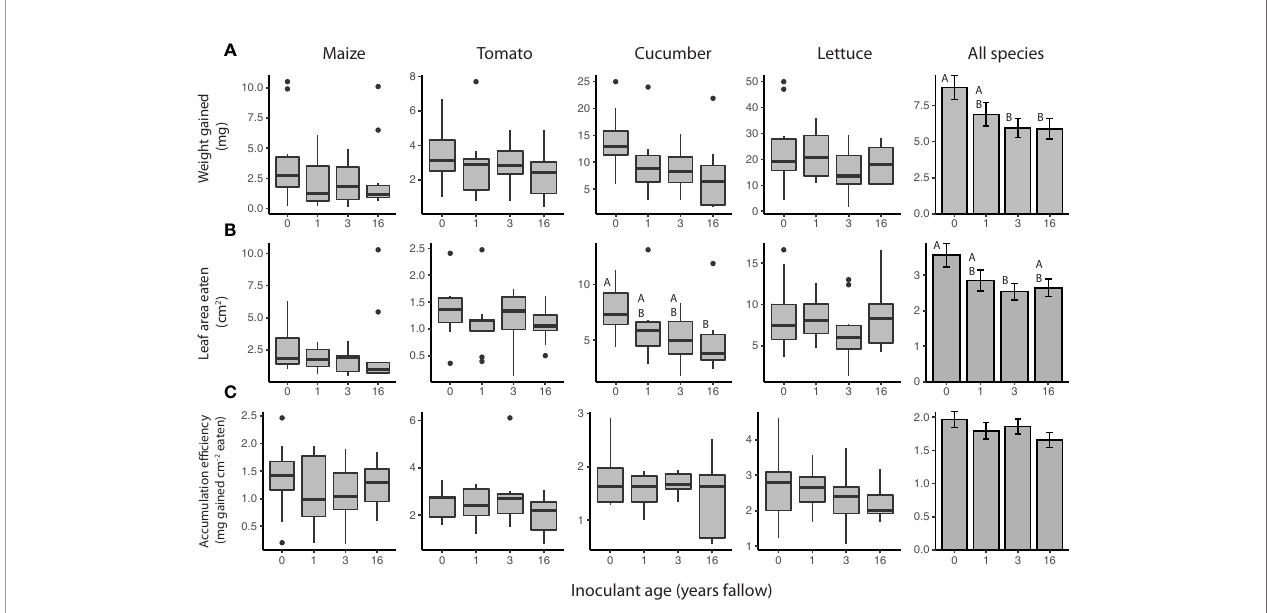
FIGURE 2 | Trichoplusia ni resistance of maize ( Z. mays ), tomato ( S. lycopersicum ), cucumber ( C. sativus ), and lettuce ( L. sativa ) plants inoculated with agricultural (0 year) or fallow microbiomes of different ages (1, 3, or 16 years post-agriculture) in a no-choice assay. Resistance measured as (A) weight gained (B) amount of tissue eaten by T. ni larvae ( c. 6 d old at start), as well as their (C) biomass accumulation ef fi ciency after feeding for 3 (maize, tomato, and cucumber assays) or 4 d (lettuce assays). N = 8-12 replicates per species × inoculant age treatment after omitting insects that died, lost weight, or did not eat. Boxes enclose the middle 50% of values, with the 50 th percentile indicated by the midline and error bars spanning 1.5 times the interquartile range in both directions; values outside this range are indicated as black dots. Bar plots show estimated marginal means (± SE) averaged across species, and inoculant and greenhouse spatial blocks (see model outputs in Table 2 ). Letters above the boxes/bars indicate signi fi cant differences between inoculant age levels within plant species for the boxplots and across all species for the bar plots ( a = 0.05).